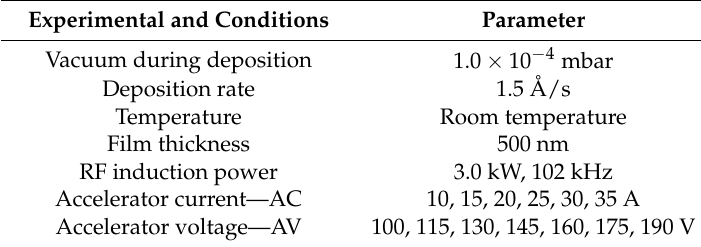
Table 1. The conditions of experiment and its parameters.